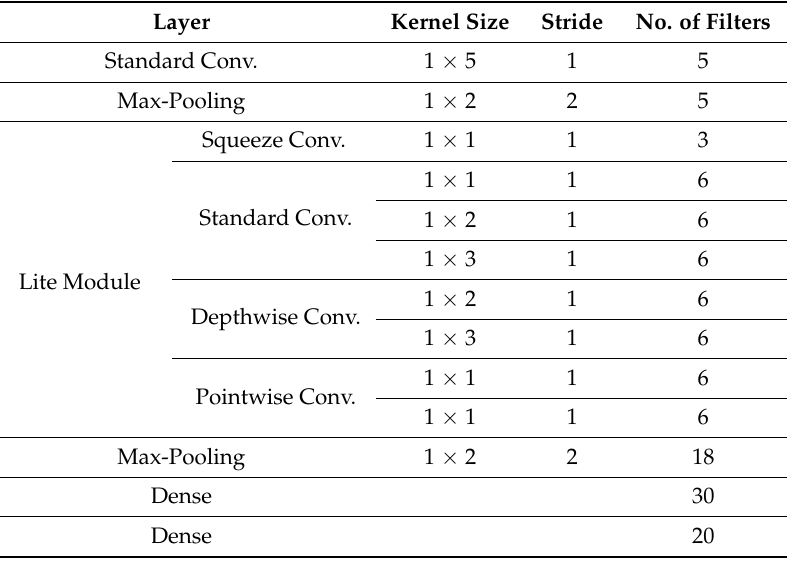
Table 1. Summary of the basic LiteNet model for this work. Layer Kernel Size Stride No. of Filters Standard Conv. Squeeze